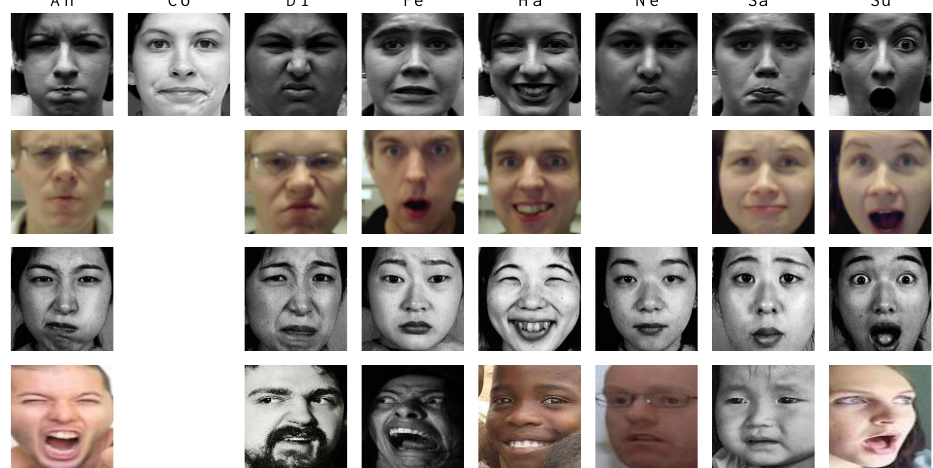
Figure 3. Samples of different expressions from four databases. From top to bottom is the Extended Cohn–Kanade database (CK+), Oulu-CASIA, Japanese Female Facial Expressions database (JAFFE), and RAF-DB. An, Co, Di, Fe, Ha, Ne, Sa, and Su stand for Anger, Contempt, Disgust, Fear, Happiness, Neutral, Sadness, and Surprise,